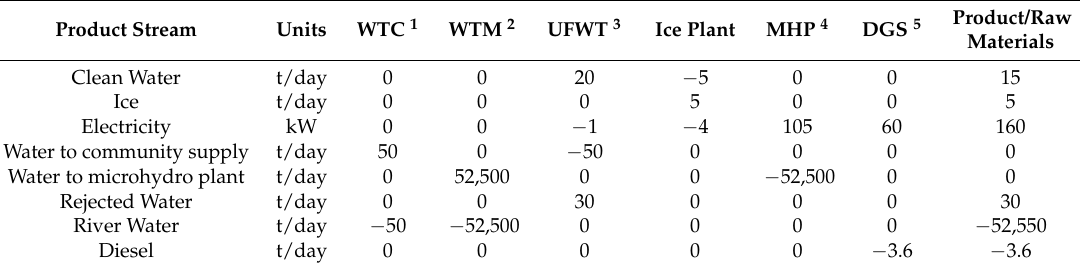
Table 3. The balanced process matrix of case study 2.